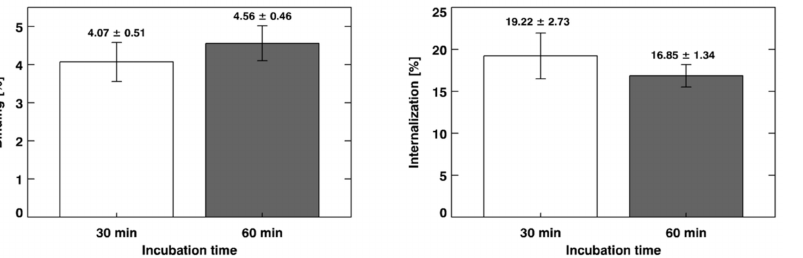
Figure 3. In vitro binding and internalization of [ 68 Ga]Ga-PSMA-11 to lymph node carcinoma of the prostate (LNCaP) cells. The results are expressed as “mean ± SD” ( n = 5).